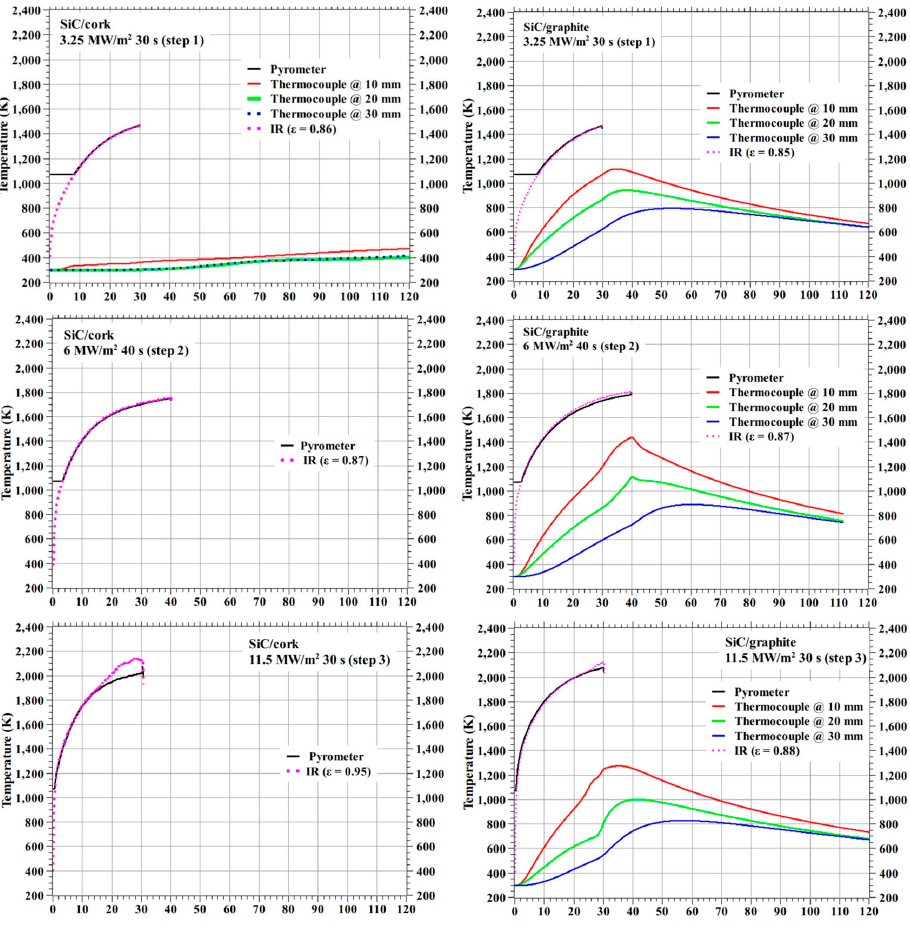
Figure 20. SiC-coated C–C specimens’ temperature responses.